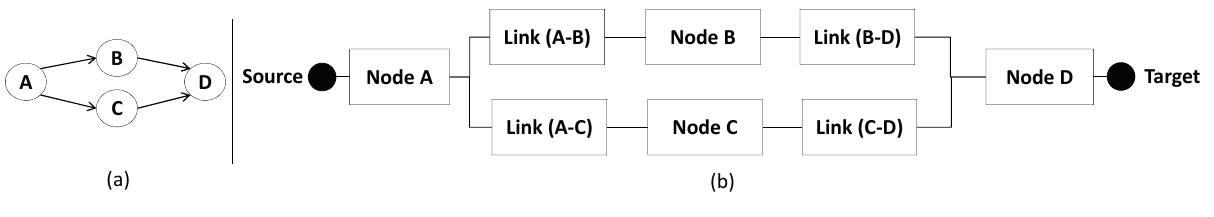
Figure 9. Example of a ( a ) network with multipath and ( b ) its RBD model.